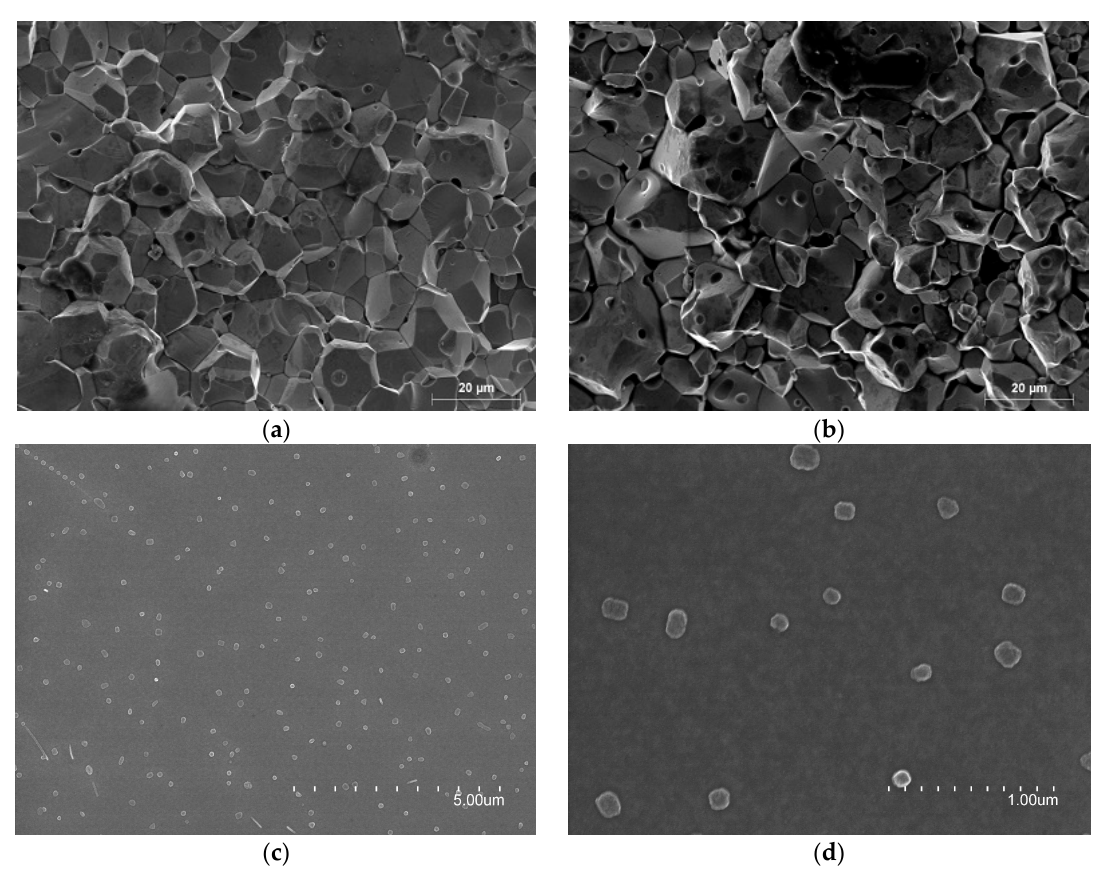
Figure 2. SEM photographs of ceramics and nanocrystalline core materials: ( a ) MnZn material composition; ( b ) NiZn material composition; ( c ) NC material composition; ( d ) NC material composition zoom in.